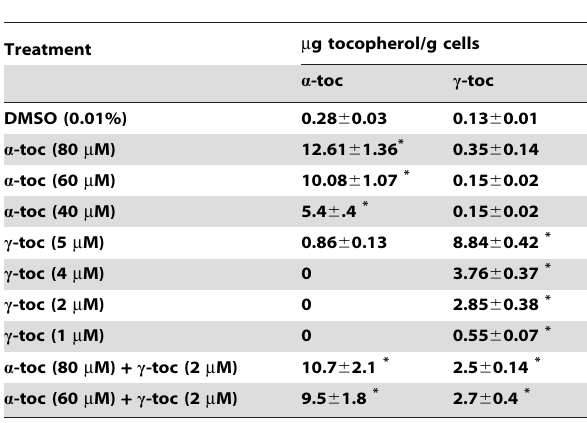
Table 1. Uptake of tocopherols by HMVECLs.